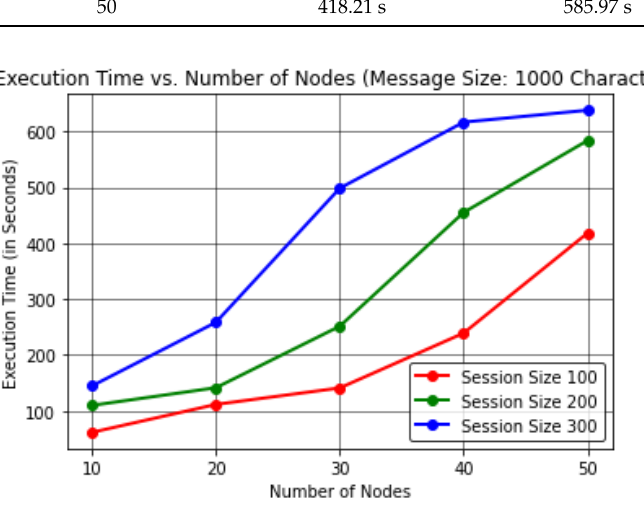
Figure 9. Execution time vs. number of nodes. Table 7. Comparison between memory consumption and number of nodes.